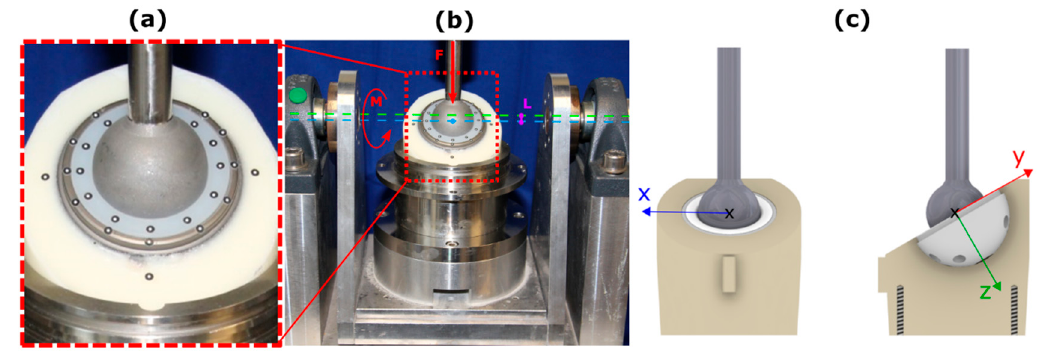
Figure 3. ( a ) Arrangement of the optical marker; ( b ) Relative motion measurement setup; ( c ) Camera coordinate system.